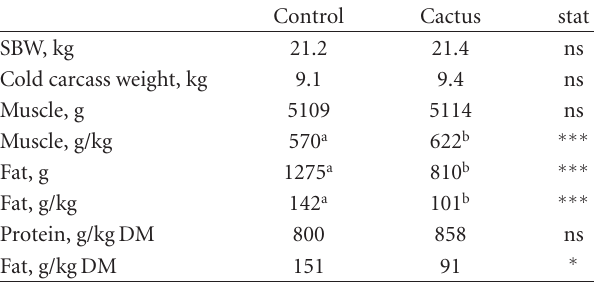
Table 2: Slaughter BW, carcass weight, and importance of fat and muscle tissues for kids receiving cactus or conventional diets.